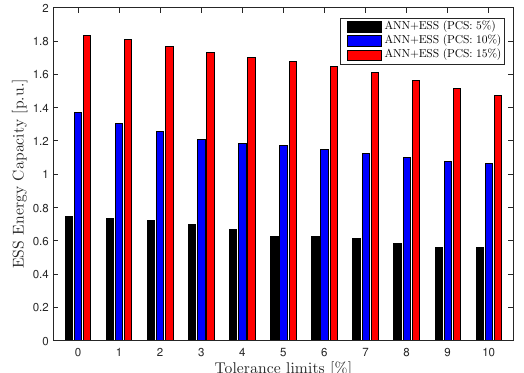
Figure 10. Energy capacity of the ANN scheme with different tolerance limits.